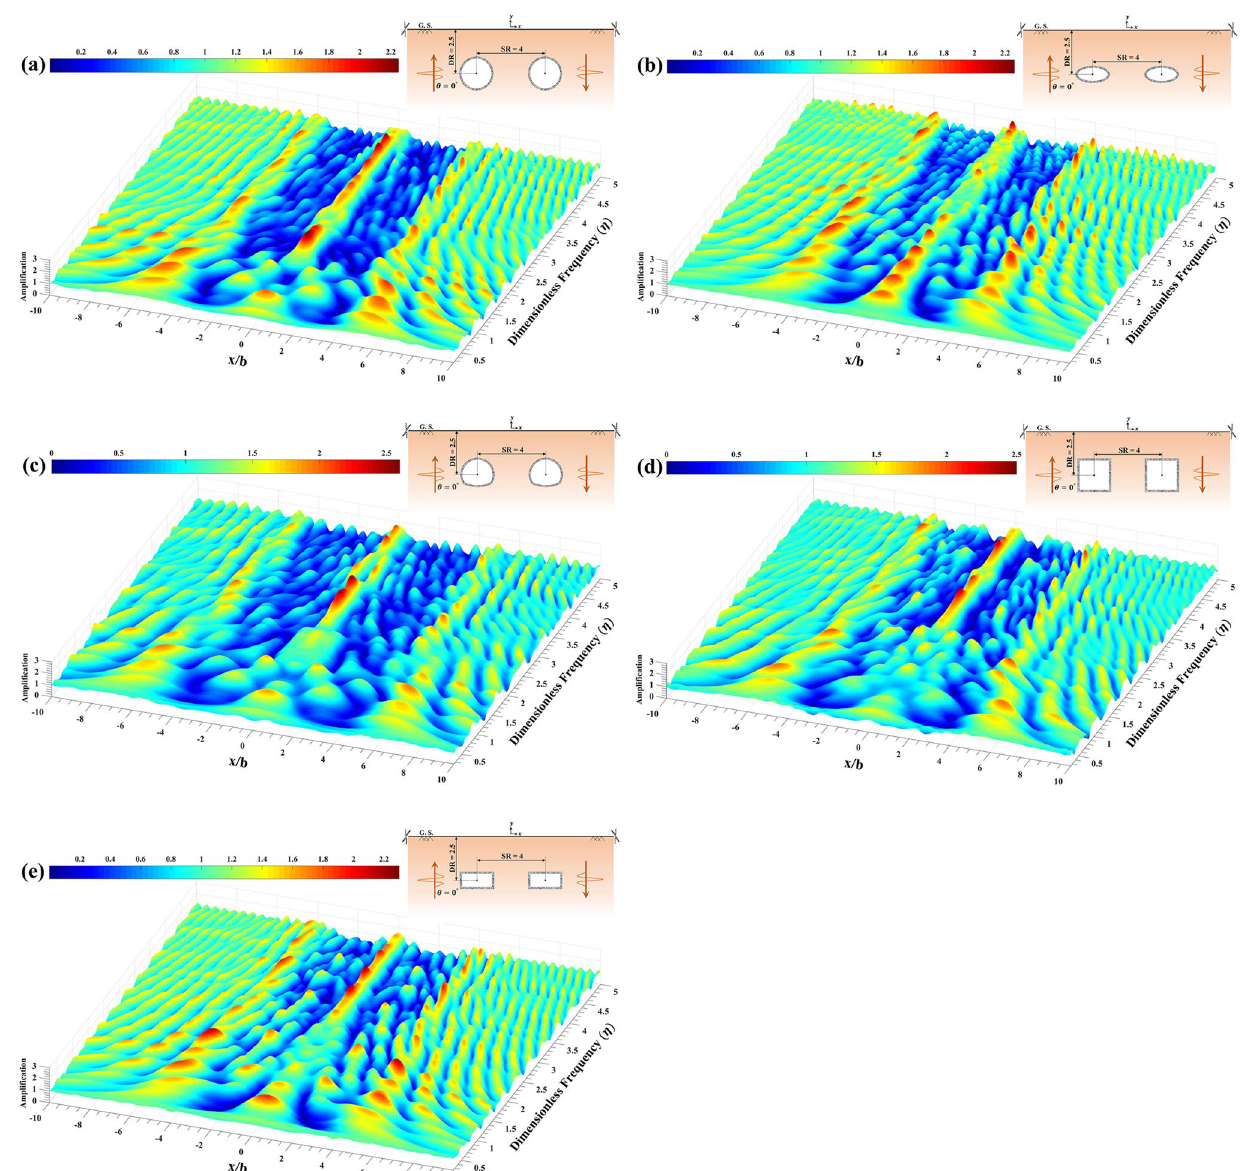
Fig. 10 The 3D amplification of the ground surface versus different dimensionless frequencies for the model of twin a circular-, b elliptical-, c horseshoe-, d square- and e rectangular-shaped lined tunnels subjected to vertical incident SH